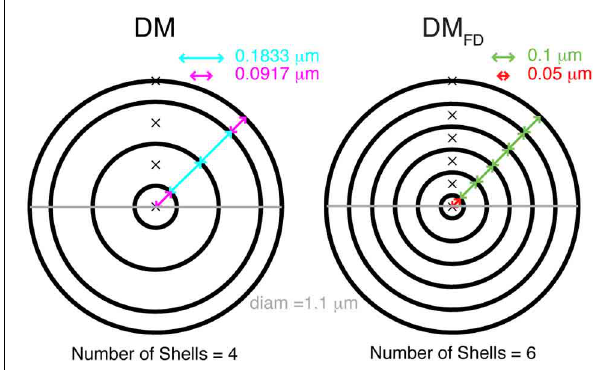
FIGURE 1 | Cytosolic compartmentalization for diffusion from membrane toward the center of a cylindrical compartment. Schematic diagram shows two different ways of dividing the compartment volume into concentric shells. The DM mechanism (left) has a fixed number of shells and the depths of all shells vary so that the sum equals the compartment diameters, the outer shell also has a smaller depth than subsequent shells. In the DM FD mechanism (right) all shells have an identical, fixed depth except for the core shell whose depth is adjusted to get the correct compartment diameter. The number of shells is given by compartment